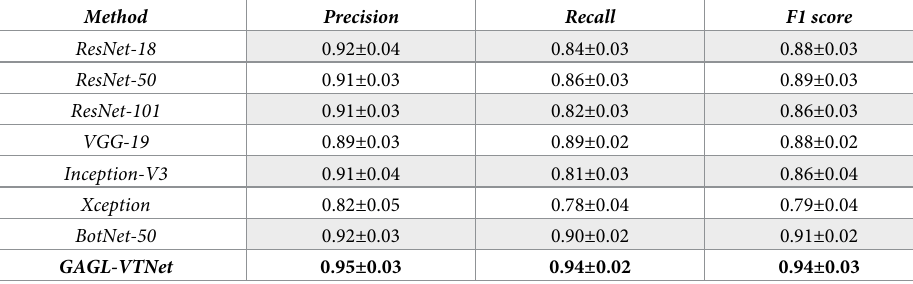
Table 2. Comparison of gland classification using different